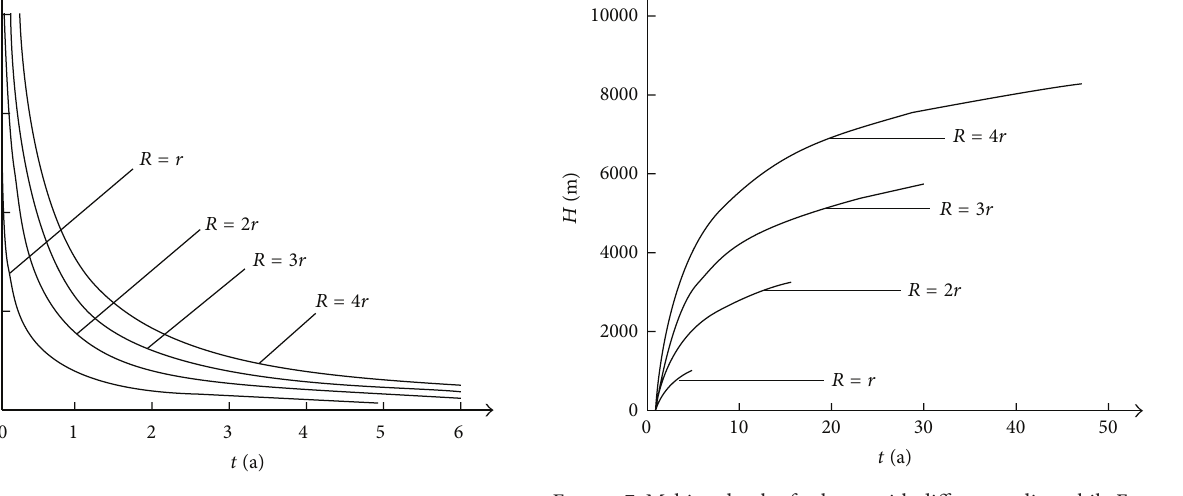
Figure 5: Melting velocity of spheres with different radius.